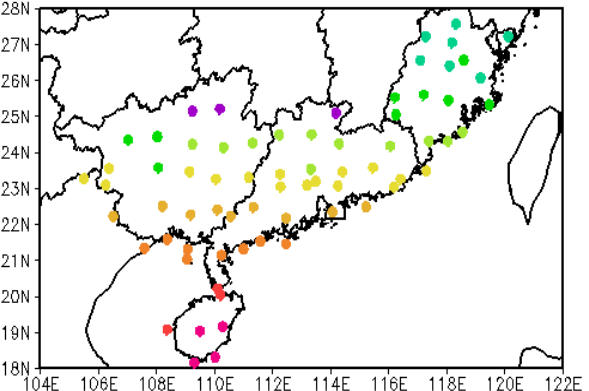
Figure 1. Distribution of representative stations in South China (Fujian Province, Guangdong Province, Guangxi Autonomous Region, Hainan Province).